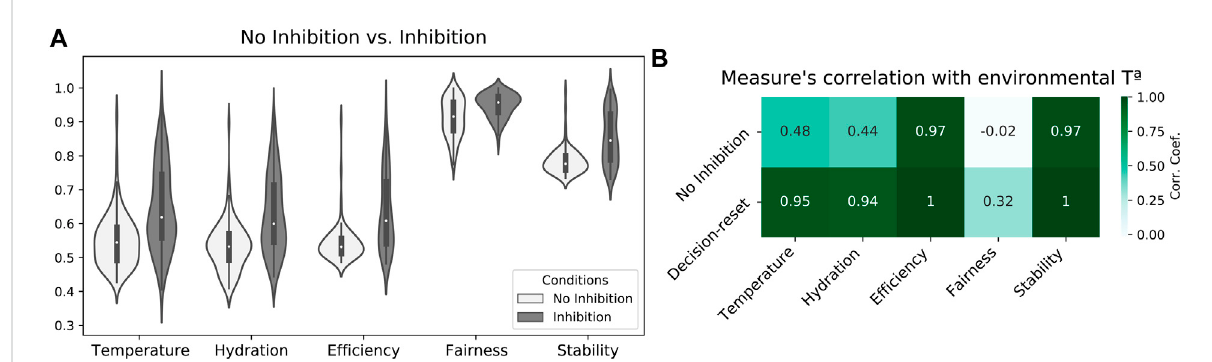
FIGURE 5 Decision-reset supports the agent ’ s internal stability. (A) Comparison of temperature and hydration internal states and ef fi ciency, fairness, and stability scores between no-inhibition (study 2) and decision-reset (study 3) conditions. (B) Correlation between internal states and game theory measures with environmental temperature for both no inhibition and decision-reset